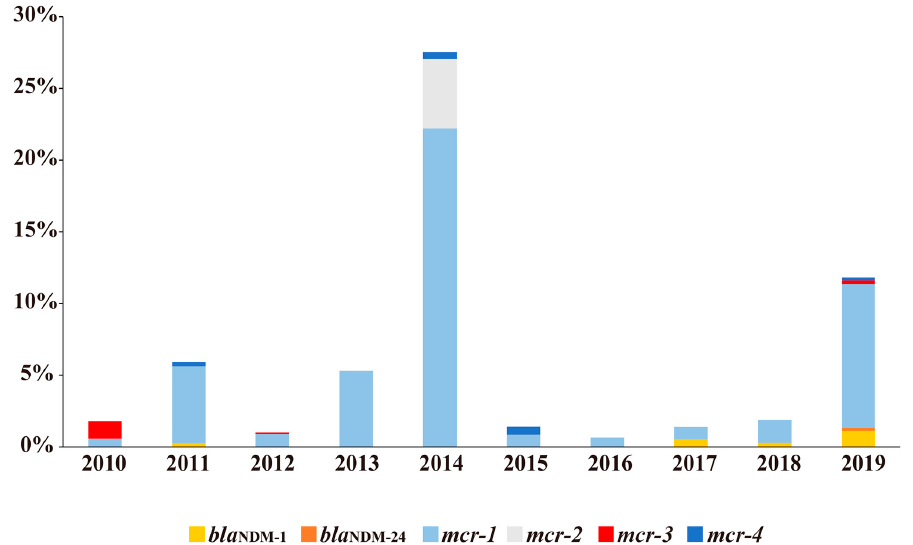
Figure 2. Positive detection rates of mcr or bla NDM gene from 2010 to 2019. Neither was detected in 2020.